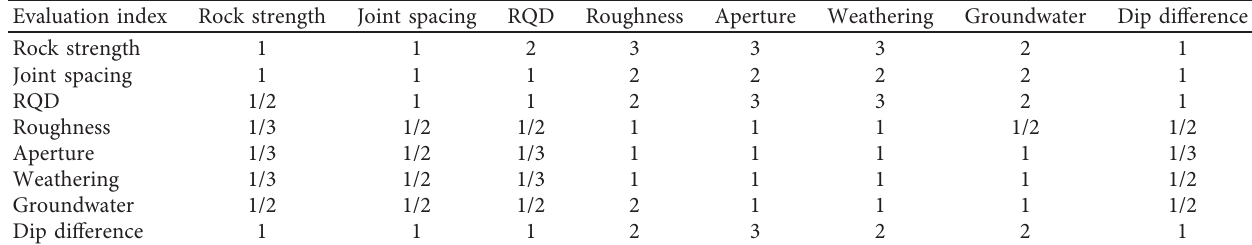
Table 6: The pairwise comparison matrix for the evaluation index of rock mass quality.